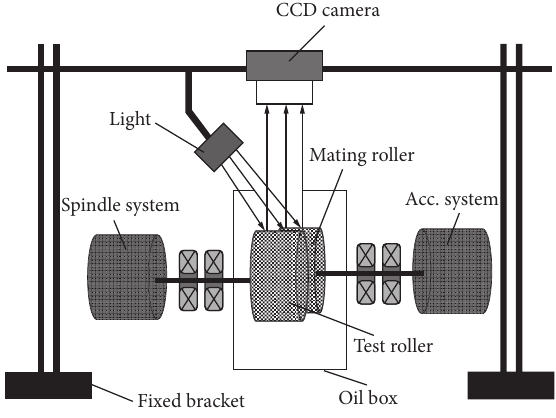
Figure 3: Structure diagram of fatigue vision